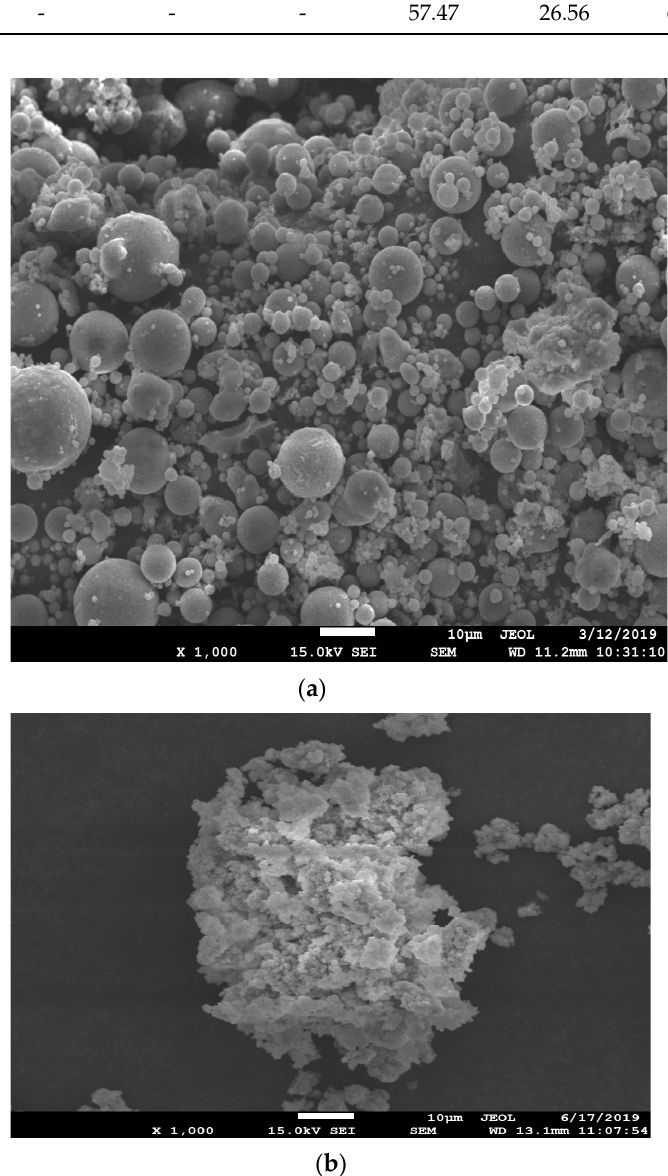
Figure 2. Micro morphologies of solid wastes ( a ) FA and ( b ) ASR.